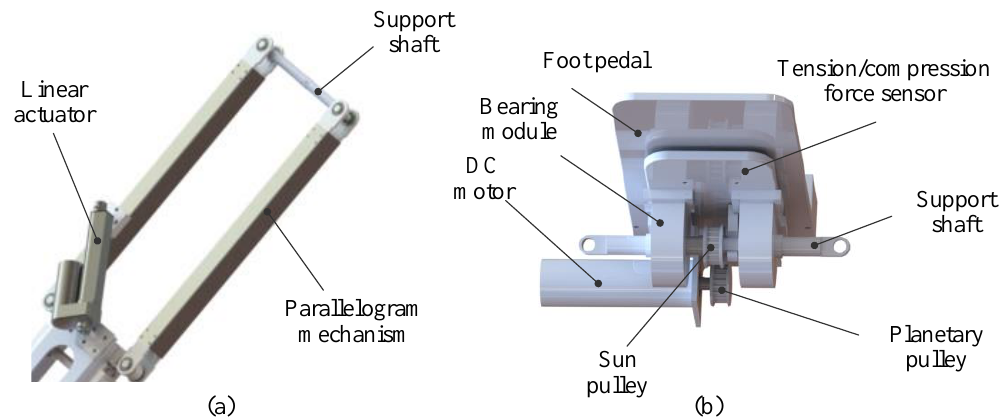
Figure 3. Adduction / abduction ( a ) and ankle ( b ) motion Figure 3. Adduction/abduction ( a ) and ankle ( b ) motion modules.